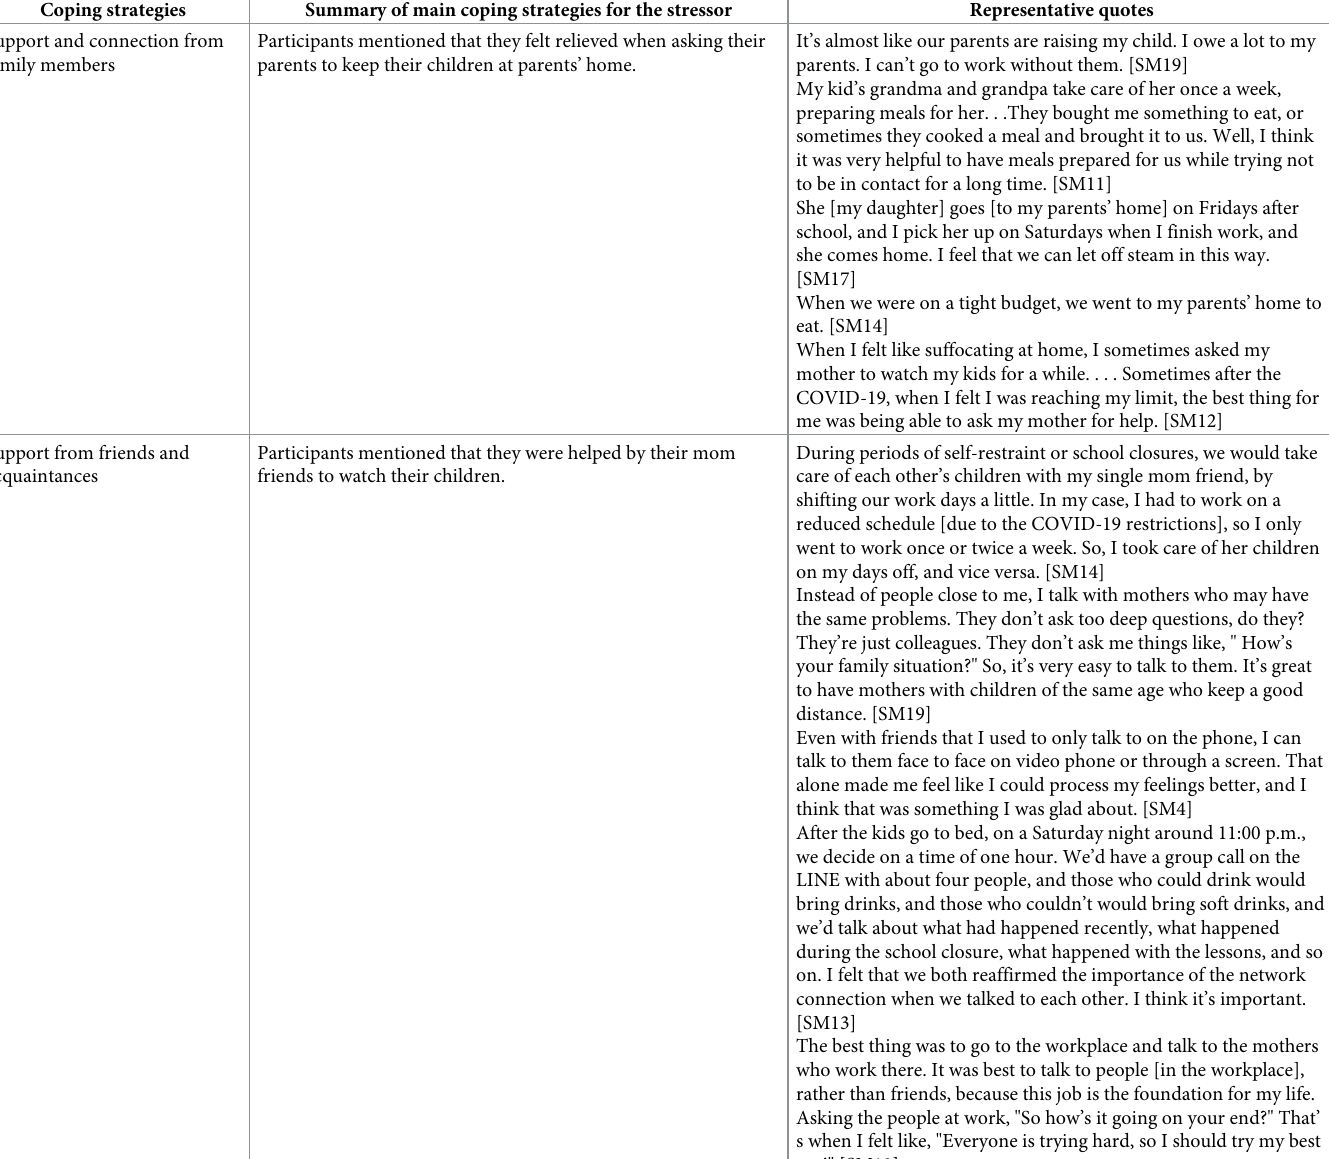
Table 3. Coping strategies among single mothers during the COVID-19 pandemic. Coping strategies Summary of main coping strategies for the stressor Representative